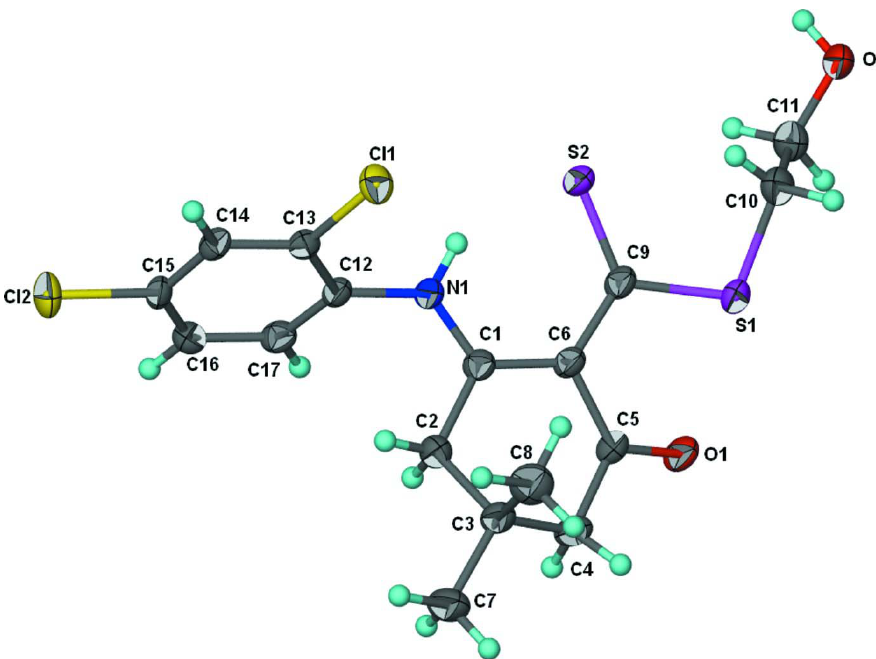
Figure 1 Anisotropic displacement ellipsoid plot (Barbour, 2001) plot of C atoms are drawn as spheres of arbitrary